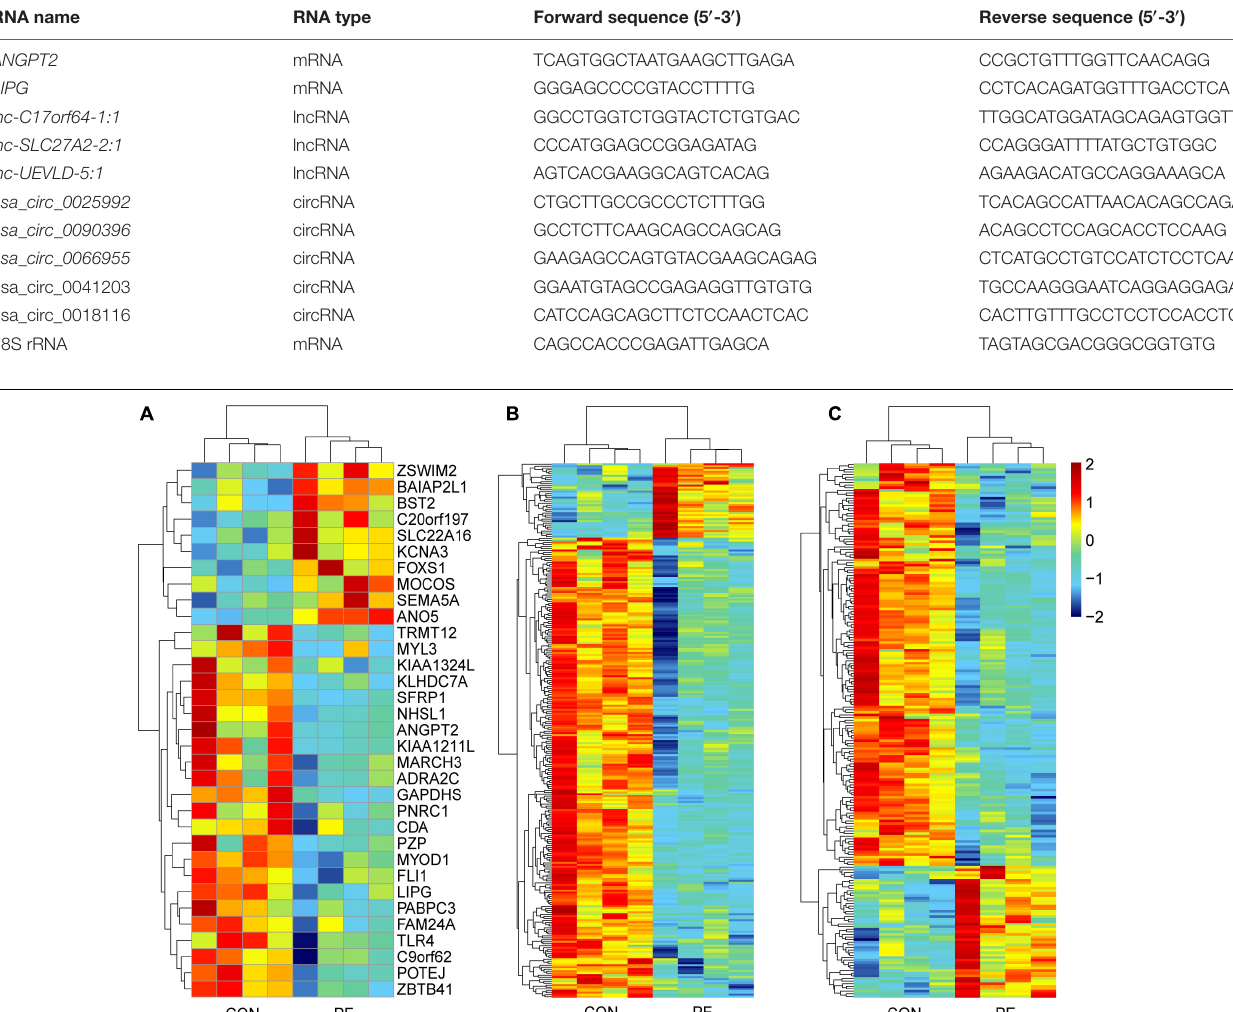
TABLE 3 | Primer sequences for PCR.